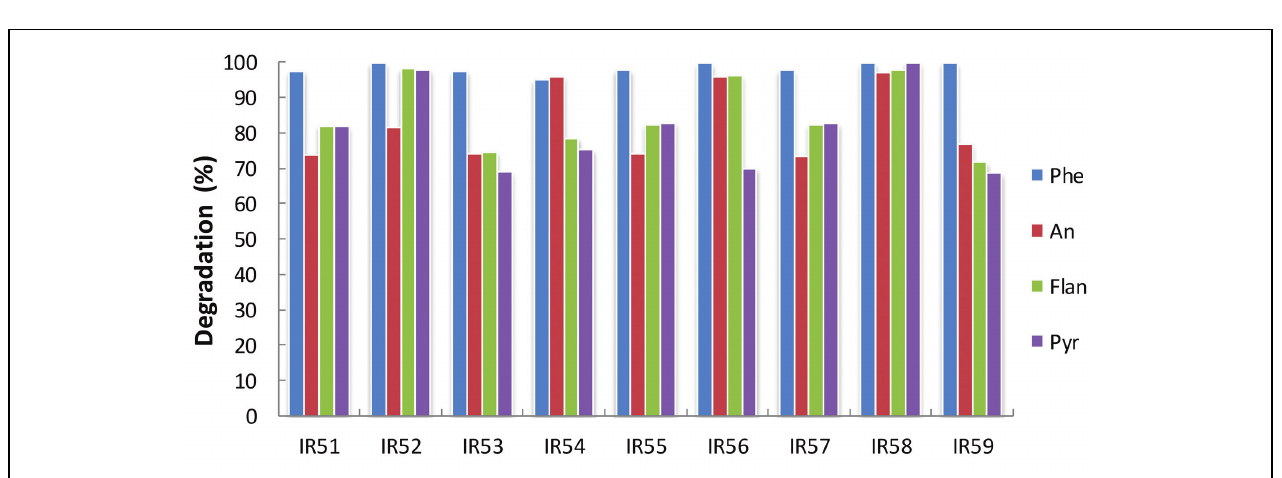
Figure 1 ). The residual PAHs were quantified with GC-MS; the degradation percentage was the average of triplicate repeats at 30 days. Phe, An, Flan, and Pyr are abbreviations of phenanthrene, anthracene, fluoranthene, and pyrene,